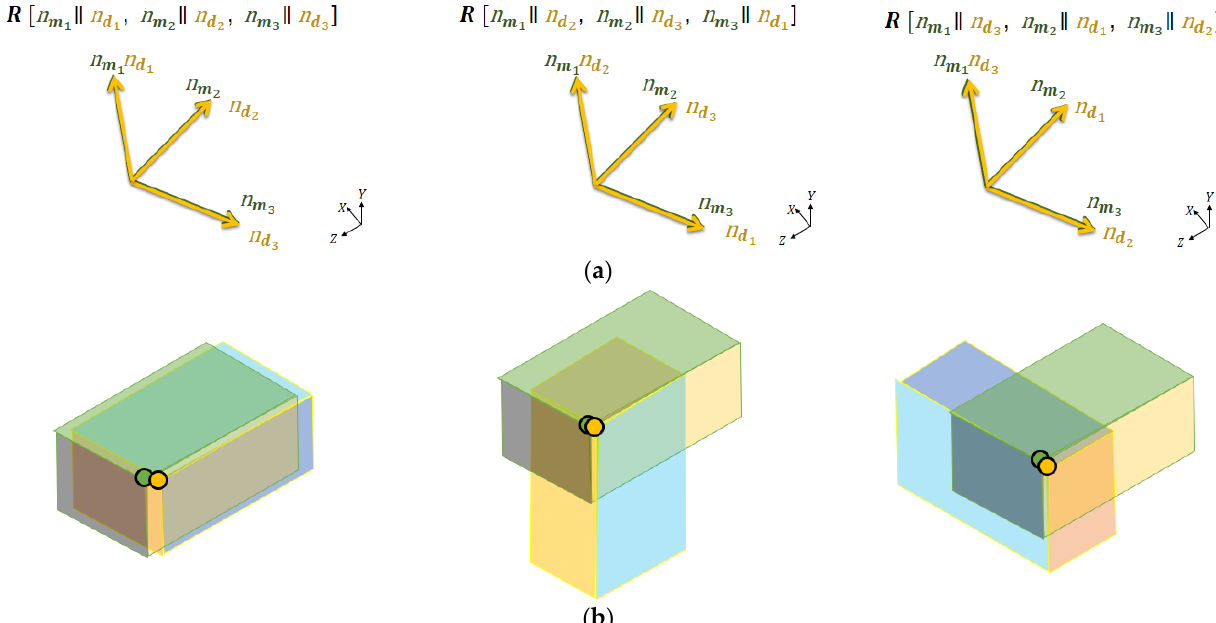
Figure 6 . Visualization of ( a ) rotation matrices obtained after alignment of the corresponding plane normal in different combinations and, ( b ) their respective rotation effect on the as-built model relative to an as-planned model .